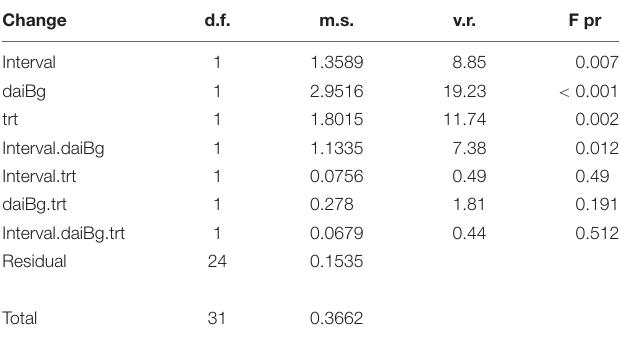
TABLE 1 | Accumulated analysis of variance table from logistic regression model: interval ∗ daiBg ∗ trt where the ∗ operator indicates that both the main effects and the interaction of the factors were estimated.